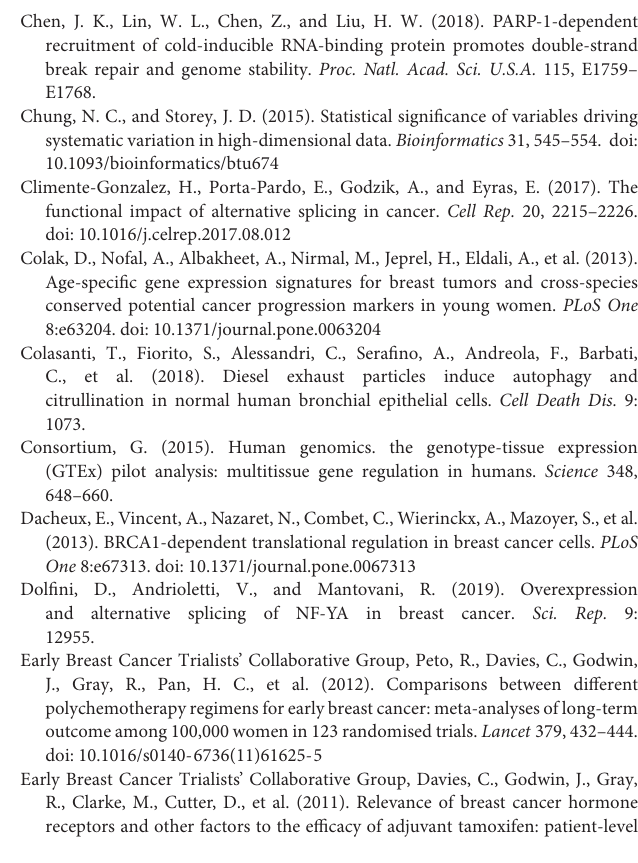
FIGURE S6 | External validation of CIRBP (A) , FAM110B (B) , ACAT1 (C) , ACAT2 (D) , ACAA1 (E) , ALOX15B (F) , and DHCR7 (G) by UALCAN. ALOX15B expressed lowly in BRCA; CIRBP, FAM110B, ACAT1, ACAT2, ACAA1, and DHCR7 expressed highly in normal thyroid and BRCA. FIGURE S7 | External validation of CIRBP (A) , FAM110B (B) , ACAT1 (C) , ACAT2 (D) , ACAA1 (E) , ALOX15B (F) , and DHCR7 (G) by Linkedomics. FIGURE S8 | External validation of CIRBP (A) , FAM110B (B) , ACAT1 (C) , ACAT2 (D) , ACAA1 (E) , ALOX15B (F) , and DHCR7 (G) by cBioportal. FIGURE S9 | External validation of CIRBP (A) , FAM110B (B) , ACAT1 (C) , ACAT2 (D) , ACAA1 (E) , ALOX15B (F) , and DHCR7 (G) by Oncomine. ACAT1 and ACAT2 low-expressed, while FAM110B, ALOX15B, and DHCR7 high-expressed in tissue level in BRCA. FIGURE S10 | External validation of CIRBP (A) , FAM110B (B) , ACAT1 (C) , ACAT2 (D) , ACAA1 (E) , ALOX15B (F) , and DHCR7 (G) by CCLE. FAM110B and ALOX15B low-expressed, while CIRBP, ACAT1, ACAT2, ACAA1, and DHCR7 high-expressed in cellular level in BRCA. FIGURE S11 | The protein-protein interaction networks. (A) The protein network of fatty acid metabolism pathway from Pathcards. (B) The protein network of CIRBP, FAM110B, ACAT1, ACAT2, ACAA1, ALOX15B, and DHCR7 from String. TABLE S1 | Description of patients’ dataset. TABLE S2 | Number of ASEs and number of ASEs in different ASE type. TABLE S3 | The external validation of CIRBP, FAM110B, ACAT1, ACAT2, ACAA1, ALOX15B, and DHCR7. TABLE S4 | Summary of external